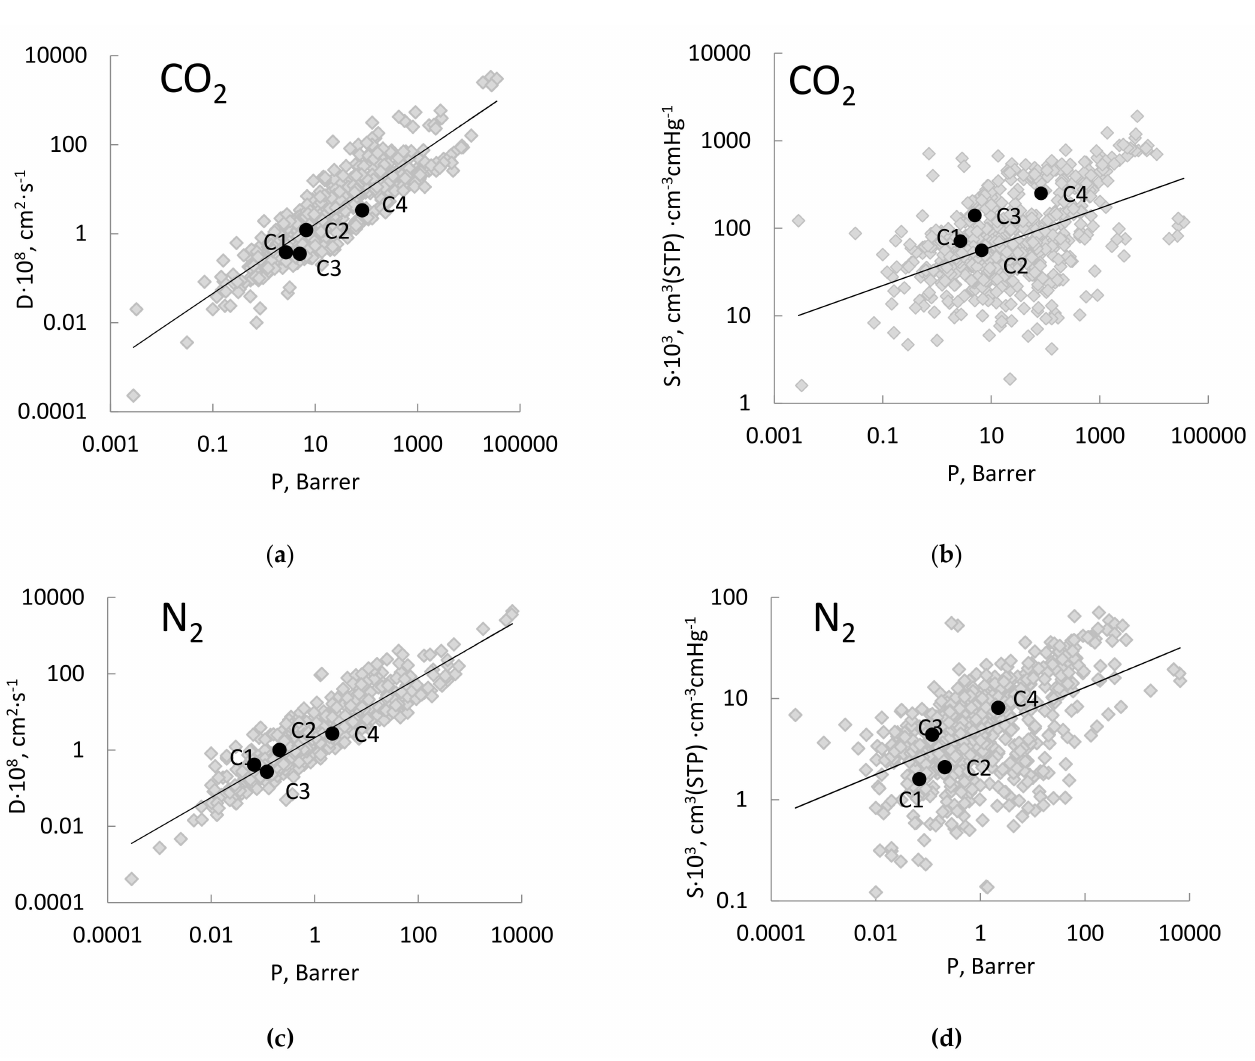
Figure 5. Diagrams of D vs. P and S vs. P for CO 2 ( a ) and ( b ), respectively) and N 2 ( c ) and ( d ), respectively). The solid black dots correspond to PAEKs C1–C4, the gray dots correspond to P, D and S of the gases for polymers from TIPS database